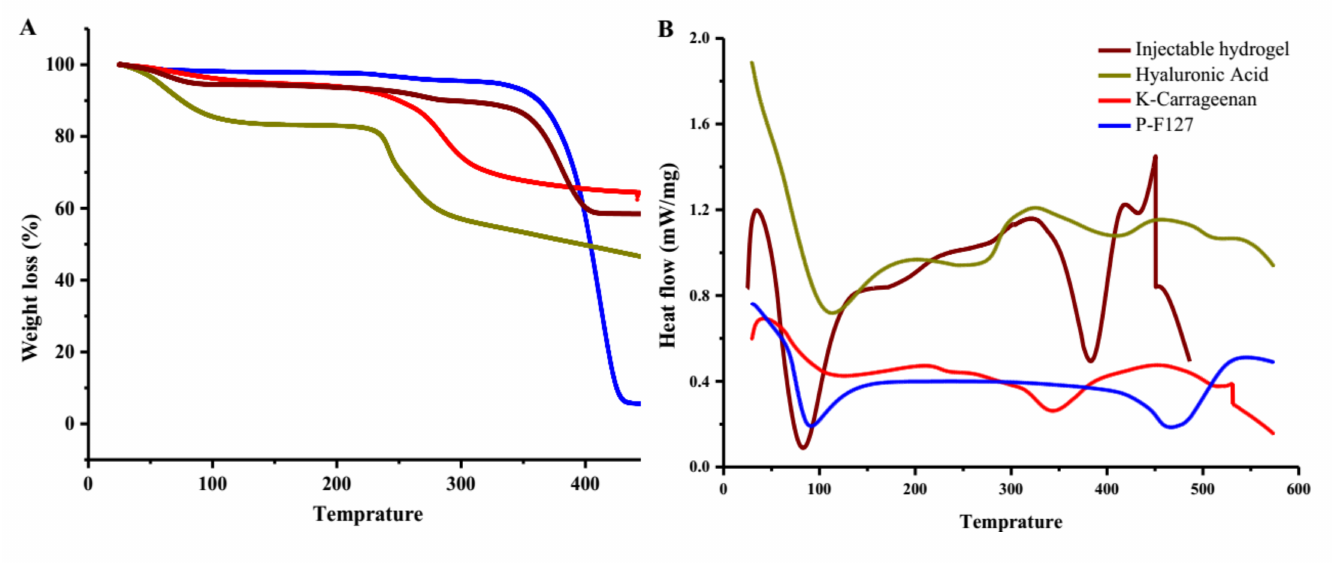
Figure 2. ( A ) Thermogram of F127, hyaluronic acid, κ -carrageenan, and injectable hydrogel; ( B ) differential scanning calorimetry of the injectable hydrogel, hyaluronic acid, κ -carrageenan, and